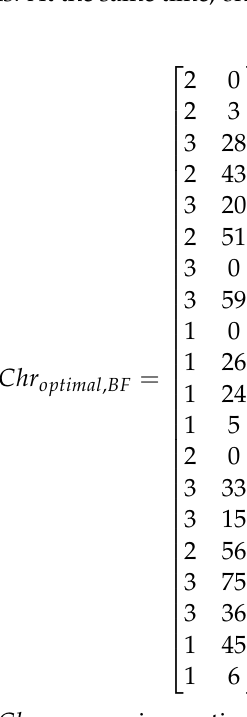
As shown in Formula (14), Chr optimal , BF is a optimal solution by BF method. On the right-hand side, the first column is the input requests, and the second is output requests, and they are combined in rows, the DC cycles. Actually, the travel distance is 205.51 of this Chr BFoptimal